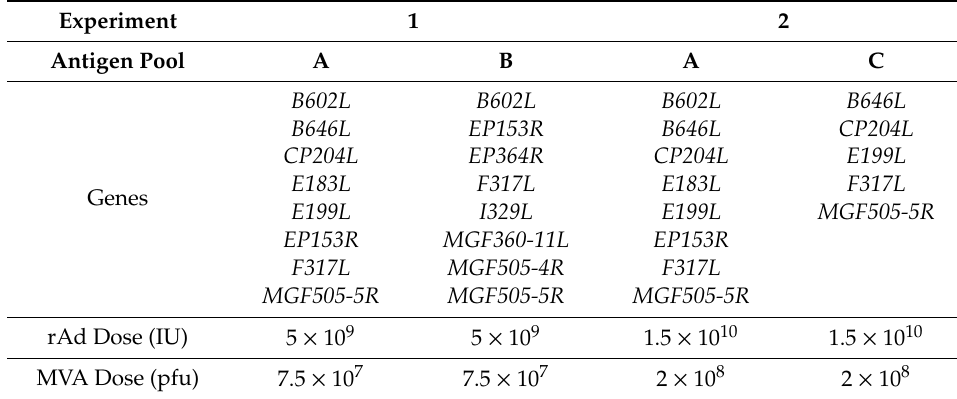
Table 1. Composition of Antigen Pools. The individual HA-tagged ASFV genes in each pool and the dose of each individual vector used in the prime and / or boost are indicated. Genes highlighted in bold were administered by rAd prime and MVA boost whereas those shown in italics by rAd prime and rAd